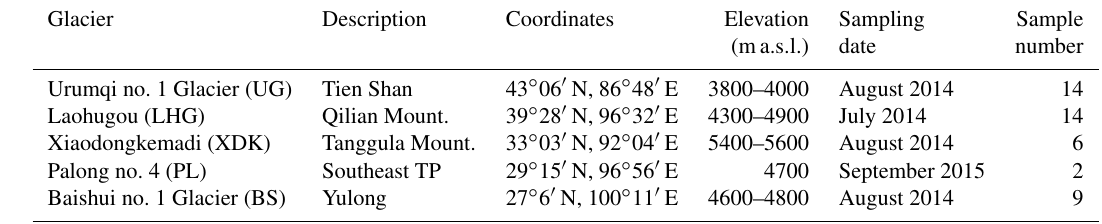
Table 1. Summary of cryoconite samples collected from five glaciers over the Tibetan Plateau and surroundings. Glacier